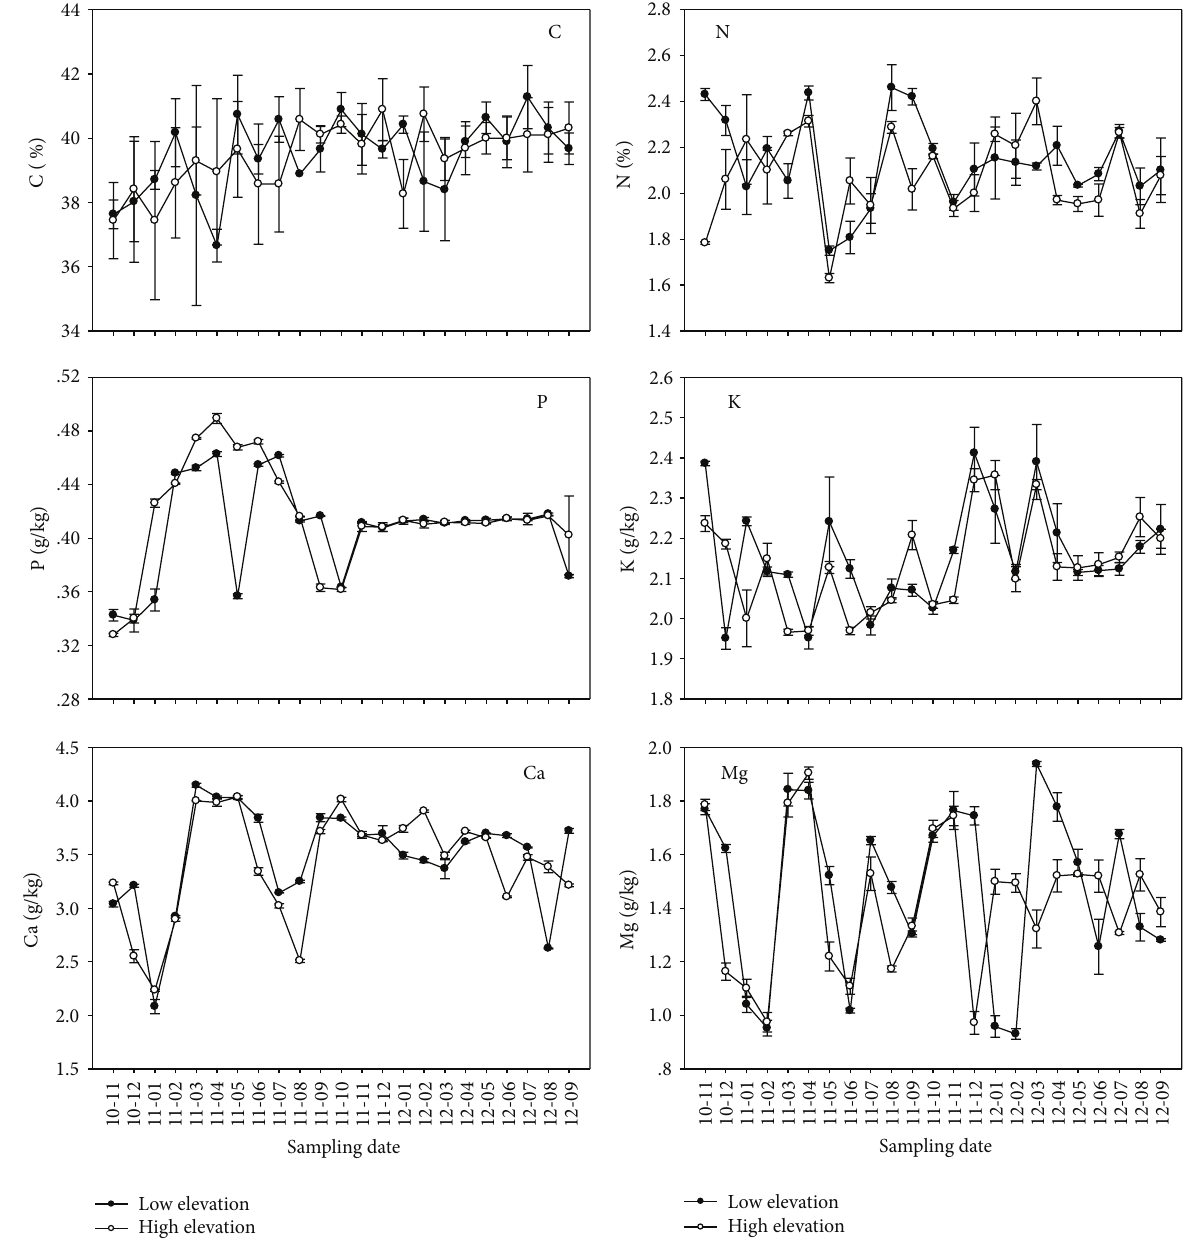
Figure 5: Dynamic variations of C, N, P, K, Ca, and Mg contents on leaf litter at two